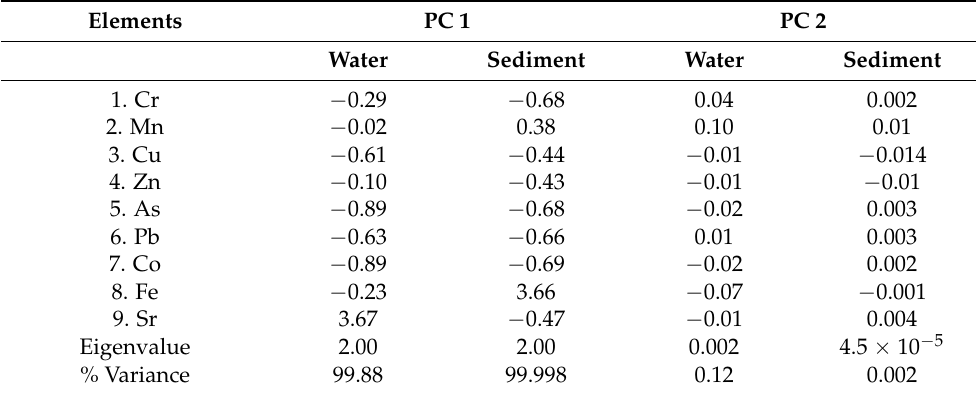
Table 8. Principal component analysis for elemental concentration in